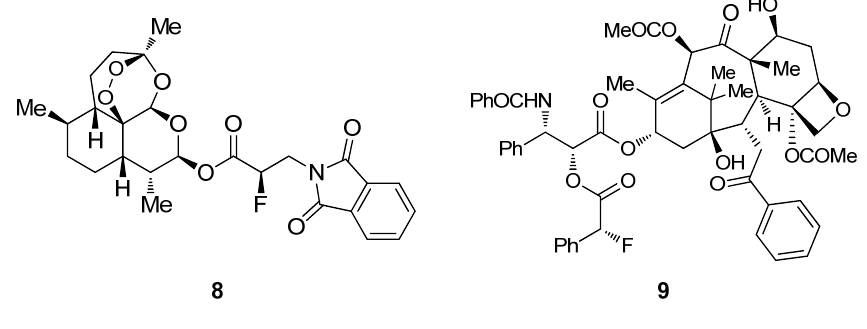
Figure 5. Fluorinated artemisinin derivative 8 and fluorinated taxol derivative 9